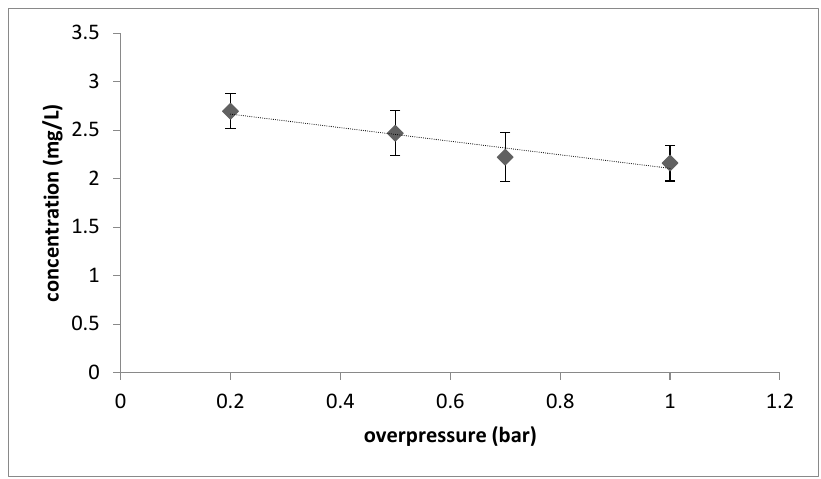
Figure 2. Decrease in isoamyl acetate concentration (mg/L) as a function of the level of overpressure (from 0.2 to 1 bar) applied during the fermentation. Error bars represent the standard deviation; the trend line was calculated with a linear model (R 2 = 0.76).